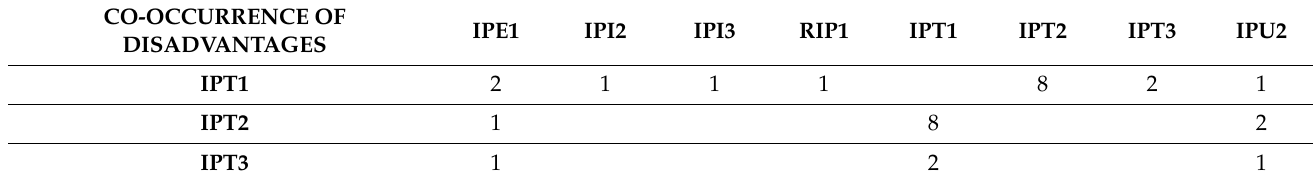
Table 4. Co-occurrence of the opinions of the students regarding the disadvantages of the digital portfolio. CO-OCCURRENCE OF